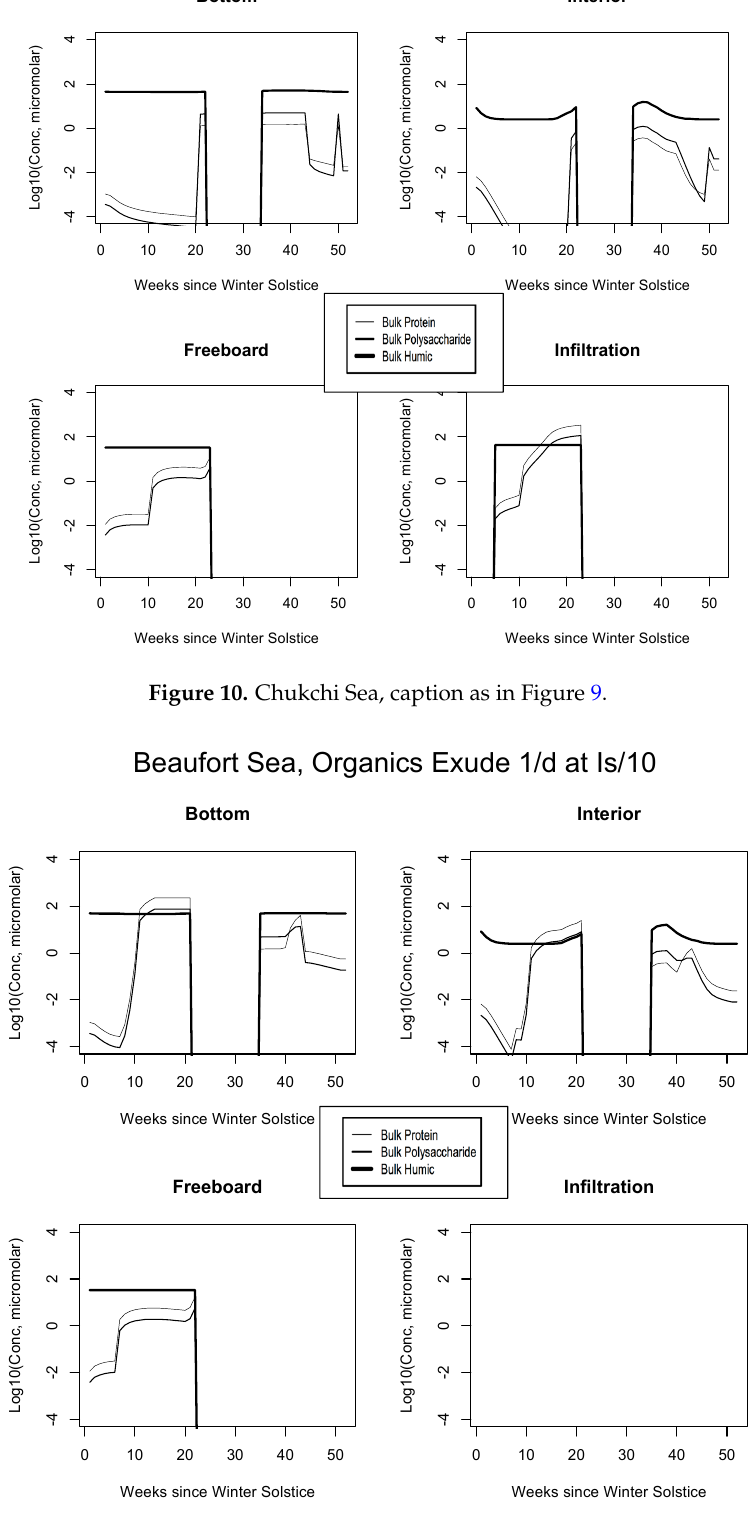
Figure 11. Beaufort Sea, caption as in Figure 9.